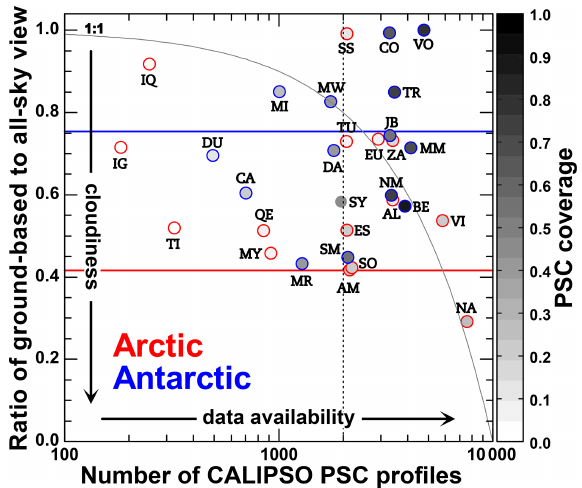
Figure 8. Number of CALIPSO PSC profiles in the 4 ◦ × 4 ◦ grid box centred around the Arctic (red) and Antarctic (blue) ground stations listed in Table 1 versus the ratio of PSC height bins as ob- served by a ground-based and a spaceborne lidar (third and sixth columns in Table 1). The colour coding refers to PSC coverage (ra- tio of PSC-containing profiles to all profiles) as shown in Figs. 2b and 5b. Horizontal lines mark the values for the entire Arctic and Antarctic, respectively. The vertical dashed line separates stations with more than 2000 CALIPSO PSC profiles from those with fewer observations. The grey line marks a scaled PSC coverage defined as (10000 − x)/ 10000. Stations to the right of this line show a com- bination of tropospheric cloudiness and PSC coverage that indi- cates favourable conditions for ground-based lidar measurements. Stations abbreviations and markings for sites with published PSC climatologies are given in Table